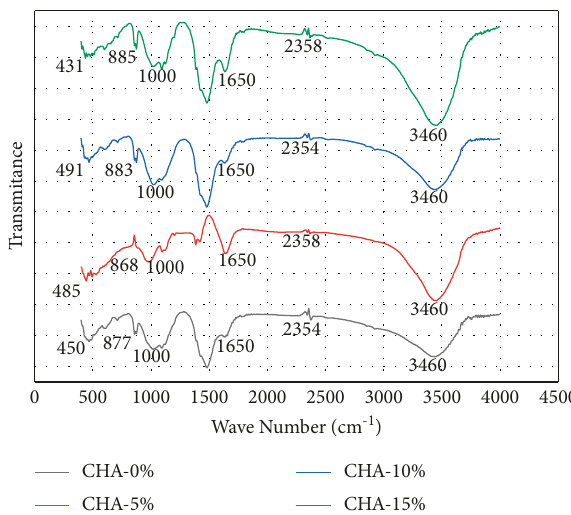
Figure 11: FTIR spectra of selected samples after 28 days of curing.